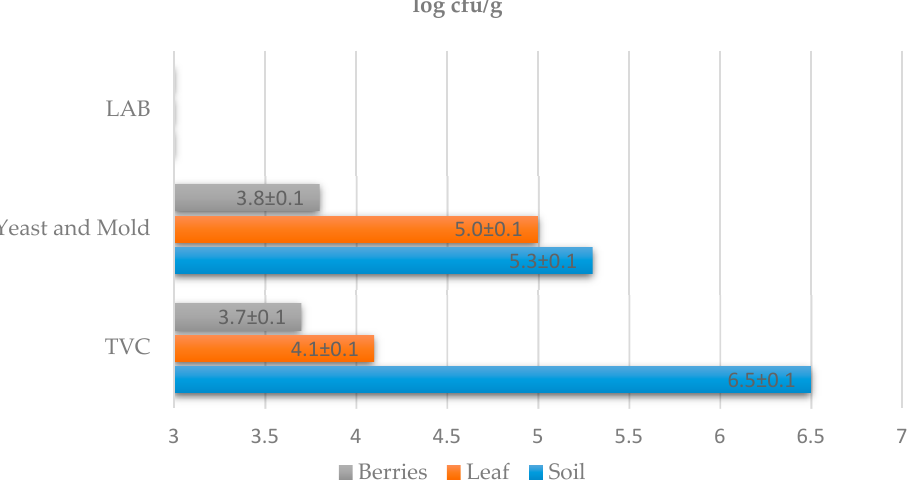
Figure 1. Quantitative microbiological culture examination of must and wine soil samples. TVC— total viable count; LAB—count of lactic acid bacteria; Yeast and Mold—count of yeasts and molds. The detection limit was <3.0 ± 0.0 log cfu/g.